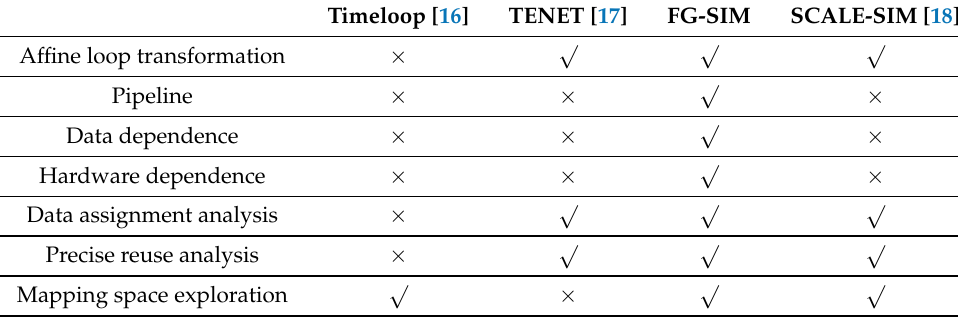
Figure 2. Schematic depicting FG-SIM, with inputs and outputs. Table 1. Comparison of Four Modeling Methods of